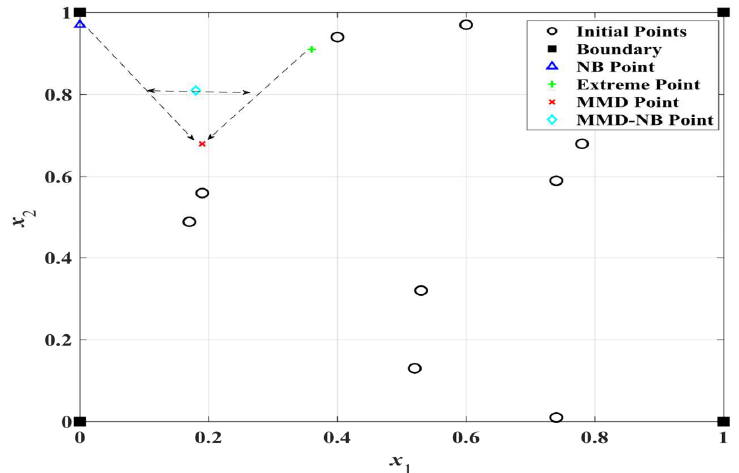
Figure 3. the distribution of MMD-NB in 2D space. Figure 3. The distribution of MMD-NB in 2D